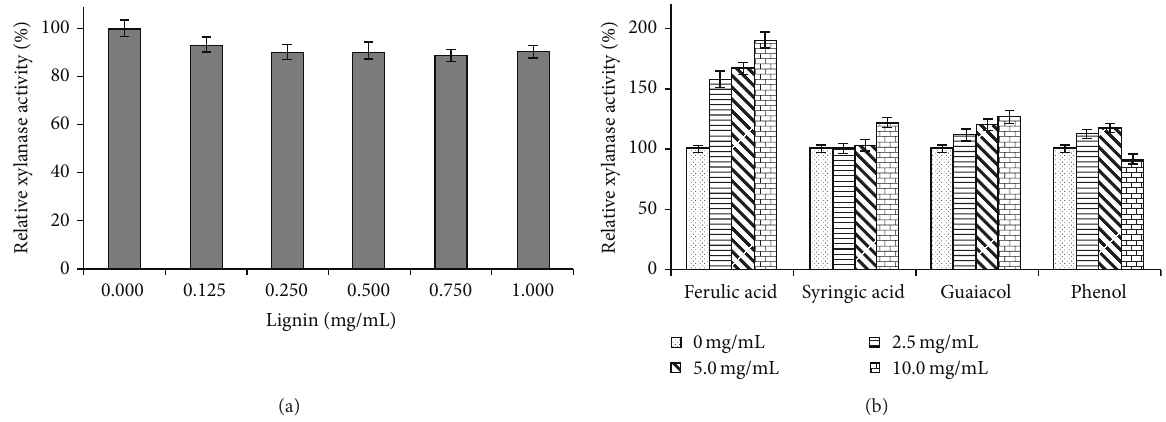
Figure 7: Influence of lignin (a) and its monomeric compounds (b) on activity of crude xylanase preparation of strain X1.